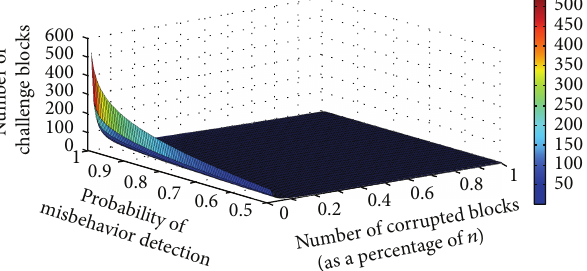
Figure 7: Number or required blocks as a challenge message under probability of misbehavior detection are from 0.5 to